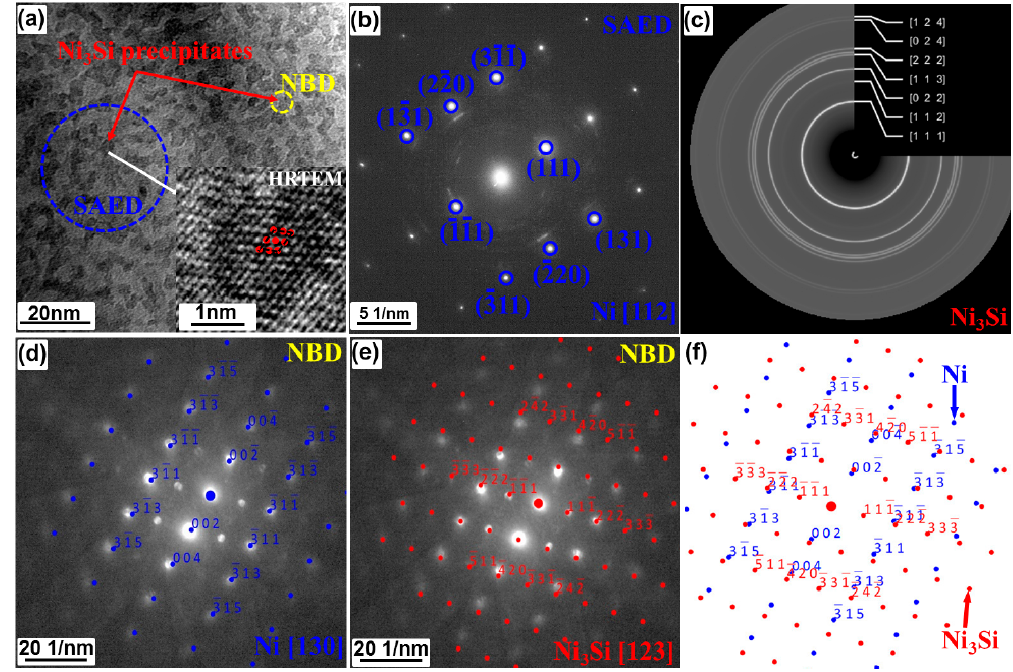
Figure 9. ( a ) Bright field and high resolution TEM images; ( b , c ) selected area electron diffraction (SAED); ( d , e ) nano-diffraction (NBD) and ( f ) simulative patterns of Ni 3 Si and Ni in 48-h-milled NiMo-2.5% SiC DPS alloys.